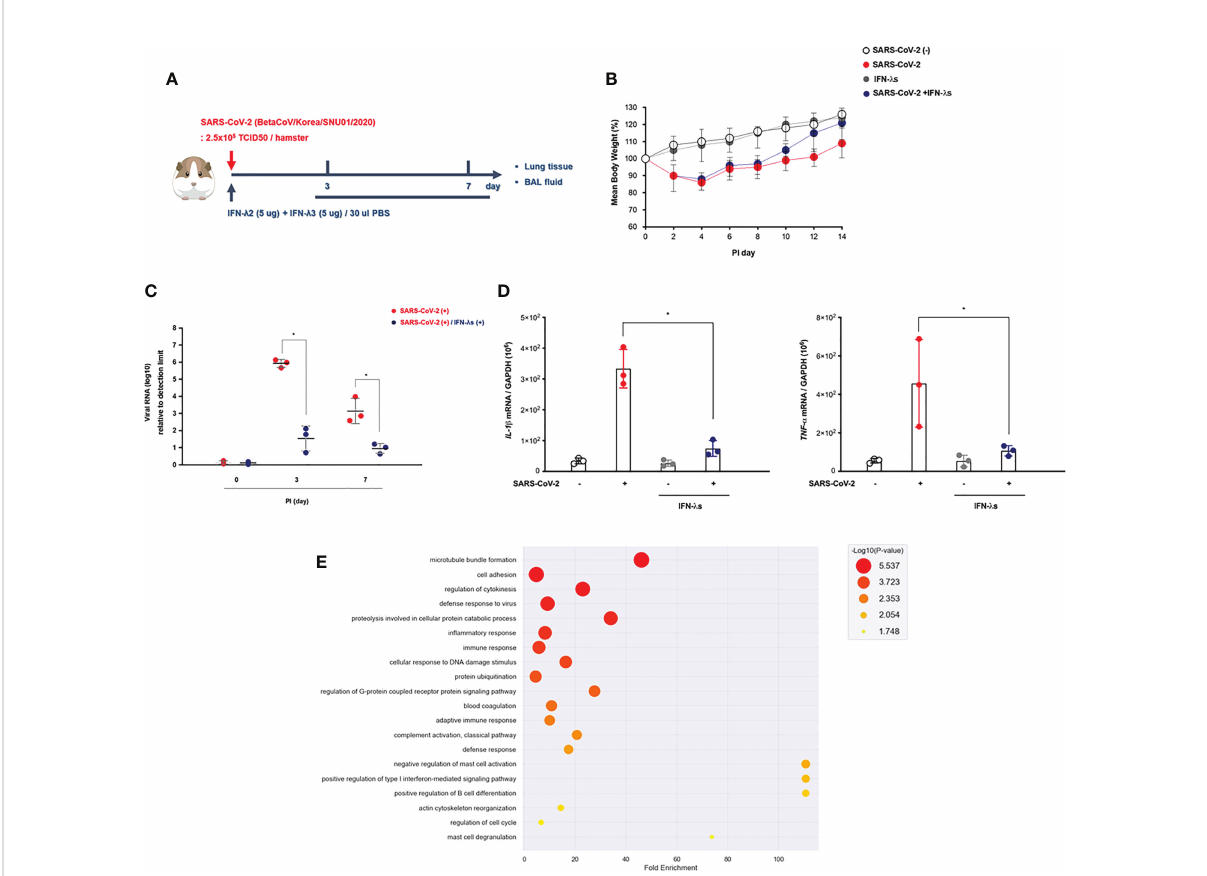
FIGURE 4 Intranasal inoculation of IFN- l promotes the viral clearance of SARS-CoV-2. (A) Schematic of the hamster model and experimental design for SARS-CoV-2 infection and intranasal inoculation of IFN- l . Syrian golden hamsters were infected with SARS-CoV-2 [3 dpi (N = 3), 7 dpi (N = 3)] and concomitantly treated with recombinant IFN- l (IFN- l 2 : 5 m g, IFN- l 3 : 5 m g with PBS 30 m l) at 3 and 7 dpi [CoV2- (N = 3)/CoV2+ 3 dpi (n = 3)/CoV2+ 3 dpi with IFN- l (N = 3)/CoV2+ 7 dpi (N = 3)/CoV2+ 7 dpi with IFN- l (N = 3)]. (B) Changes in the mean body weights of the hamsters were compared according to SARS-CoV-2 infection and intranasal inoculation of IFN- l . (C) Spike RNA levels in the lung tissue were determined at 0, 3, and 7 dpi. (D) The mRNA levels of both IL-1 b and TNF- a in response to IFN- l were determined in the lungs of SARS-CoV-2-infected hamsters at 0, 3, and 7 dpi. (E) Dot plot visualization of enriched GO terms in the lung lysates of SARS-CoV-2-infected hamsters that received an intranasal inoculation of IFN- l . The real-time PCR results were analyzed by the Mann – Whitney U test and are presented as mean ± SD values from three independent experiments. * p < 0.05 vs. non-infected